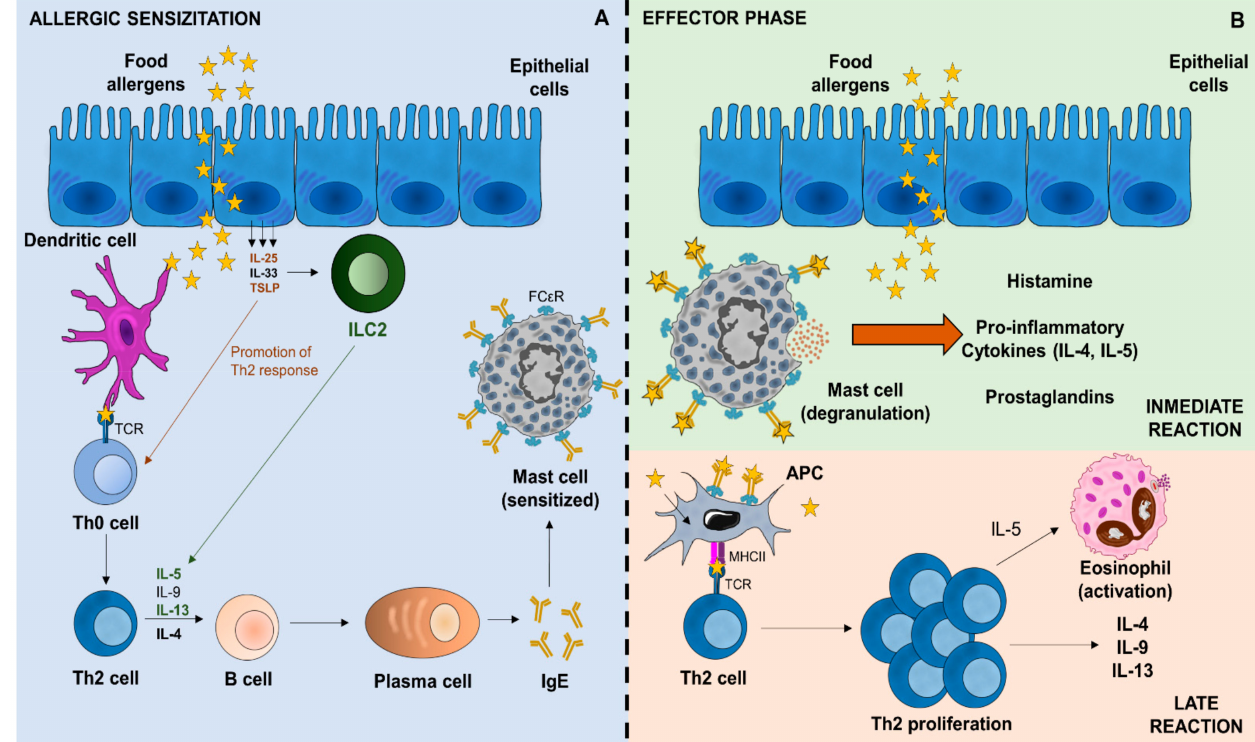
Figure 1. Immunological mechanisms involved in FA: ( A ) Food allergens are taken up by the DC and presented to Th0 cells. ILC2 have been described as IL-5 and IL-13 producers, promoting Th2 response. These cells differentiate into Th2 cells, releasing type-2 cytokines and promoting B cell differentiation into IgE-producing plasma cells. ( B ) Food allergen-sIgE binds to FC ε R placed on mast cells. Re-exposure to specific food allergen induces mast cell degranulation and promotes Th2 immune